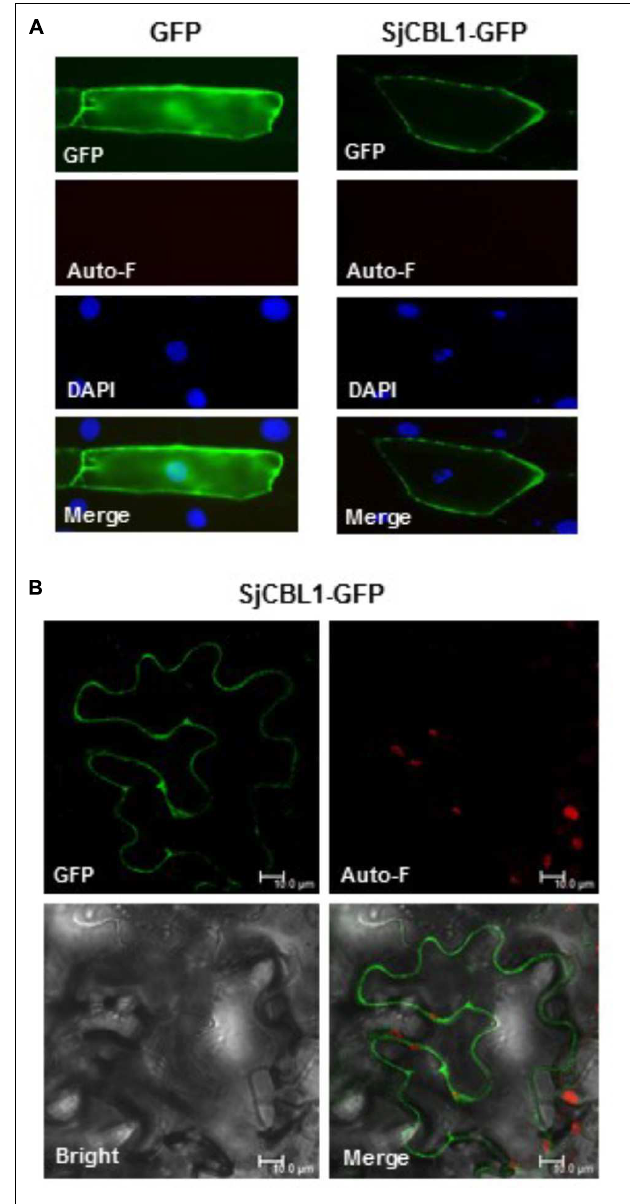
FIGURE 6 | Subcellular localization of SjCBL1-GFP protein in a plant cell. (A) Fluorescent images of onion epidermal cells. The indicated plasmids were introduced into the plant cells via the biolistic particle-delivery system. Following a 18-h incubation at 23 ◦ C, the onion cells were analyzed with a fluorescence microscope. GFP and Auto-F indicate signals of GFP fluorescence and auto-fluorescence, respectively. DAPI shows nuclei visualized by 4 (cid:48) , 6-diamidino-2-phenylindole (DAPI) staining. The merged images are shown in Merge. (B) Tobacco ( Nicotiana benthamiana ) leaf epidermal cells infiltrated with Agrobacterium carrying the SjCBL1-GFP chimeric construct. Scale bars , 10 µ